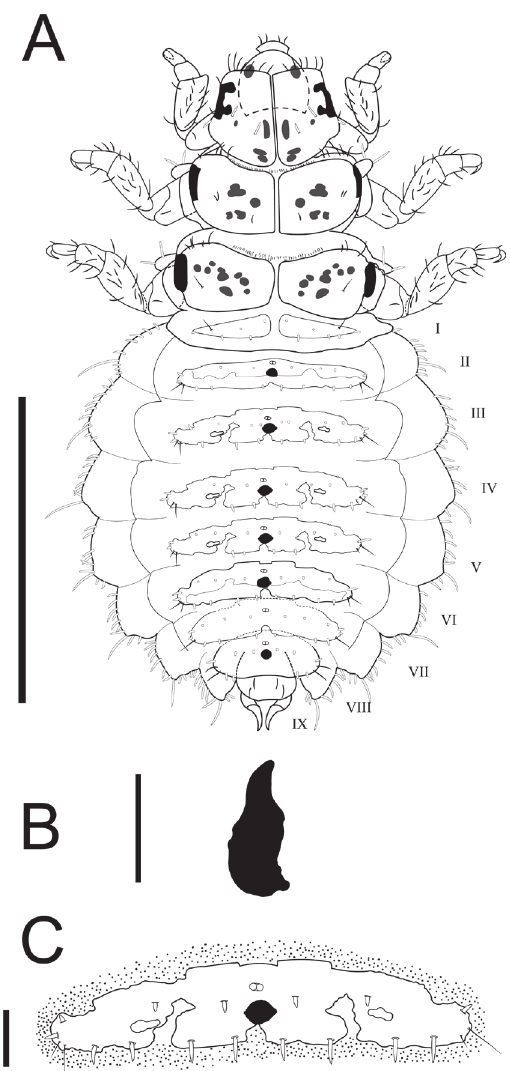
Figure 1. Larva of Mejicanotrichia harrisi Bueno-Soria & Barba-Álvarez, 1999 A habitus, dorsal B pro- pleural sclerite C tergite of abdominal segment V, dorsal. Scale bars: 1 mm ( A ); 80 µm ( B ); 130 µm ( C